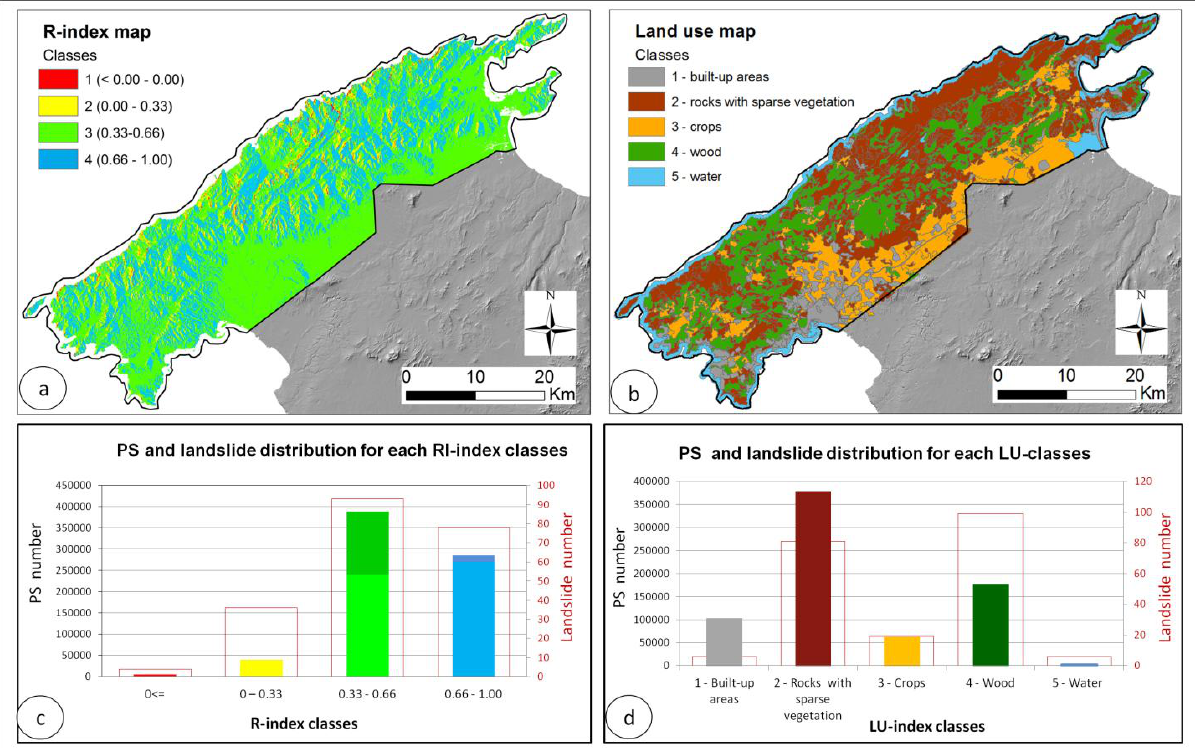
Figure 3. PS detection suitability based on Relief and Land use Visibility maps: ( a ) R-Index map of ALOS data (L-band); ( b ) Histogram of PS amount in each R-index classes. Red-contoured columns indicate the number of landslides with a certain average each R-class; ( c ) Land use map; ( d ) Histogram of PS amount and landslide number in each LU-index classes. Red-contoured columns indicate the number of landslides with a certain average each